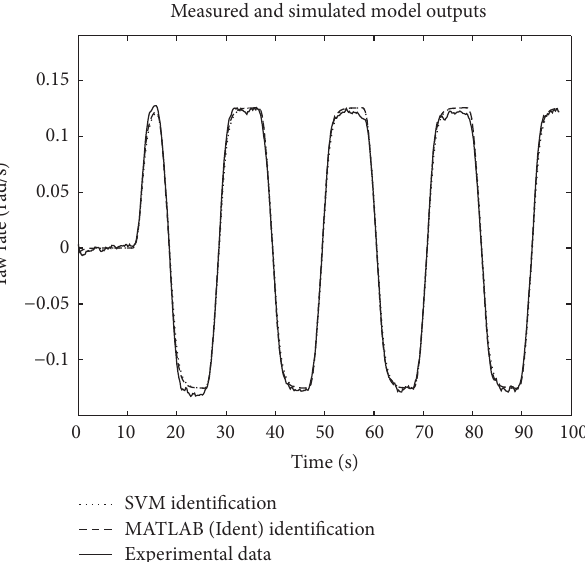
Figure 10: Comparison between the experimental yaw rate (solid line), the yaw rate of the LS-SVM identification model (dotted line), and the one of the identification model obtained with the Ident tool of MATLAB (dashed line) for a 20/20 degree zig-zag manoeuvre.